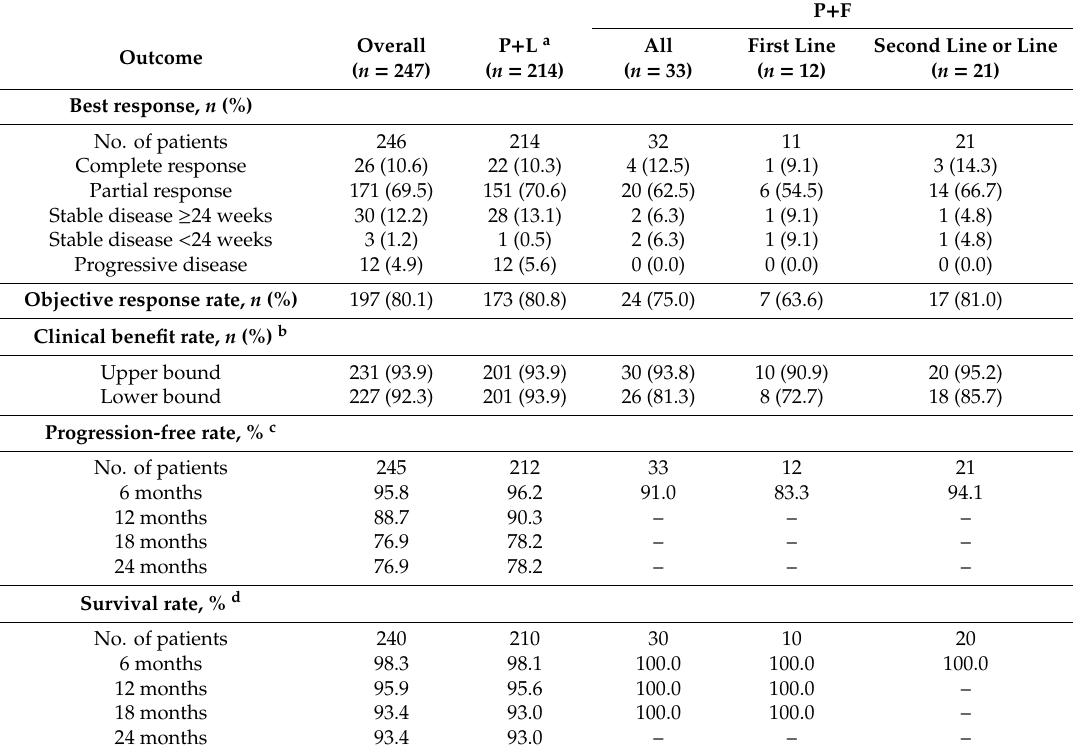
Table 4. Outcomes in patients treated with palbociclib combination